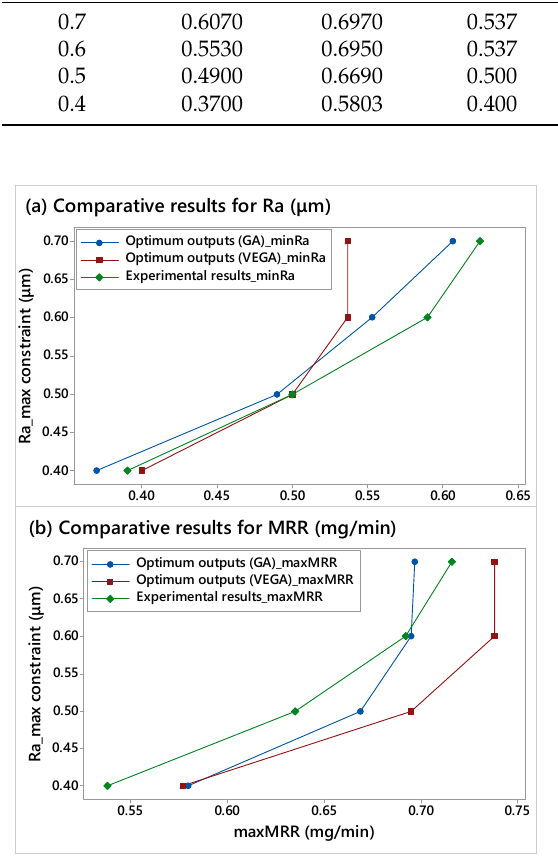
Figure 4. Comparative results between the optimization objectives of min Ra and max MRR corre- sponding to GA, VEGA, and actual experimental results of conventional abrasive flow nano-finishing process [2]: ( a ) min Ra , ( b ) max MRR .